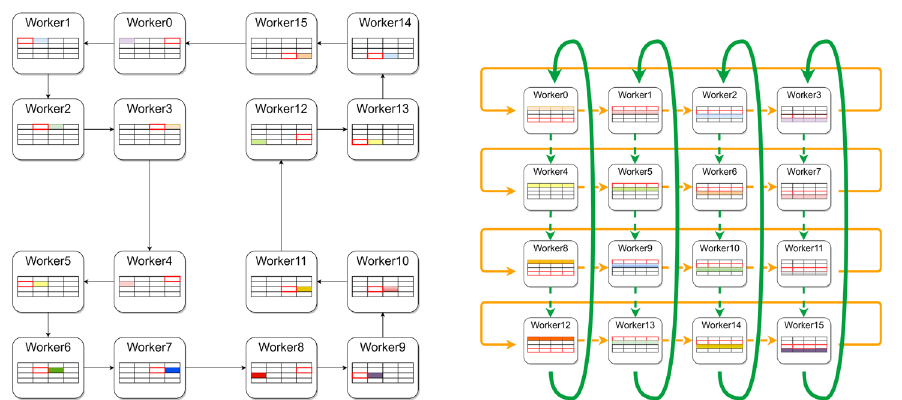
Fig. 1 Topology of AllReduce- based synchronization algo-